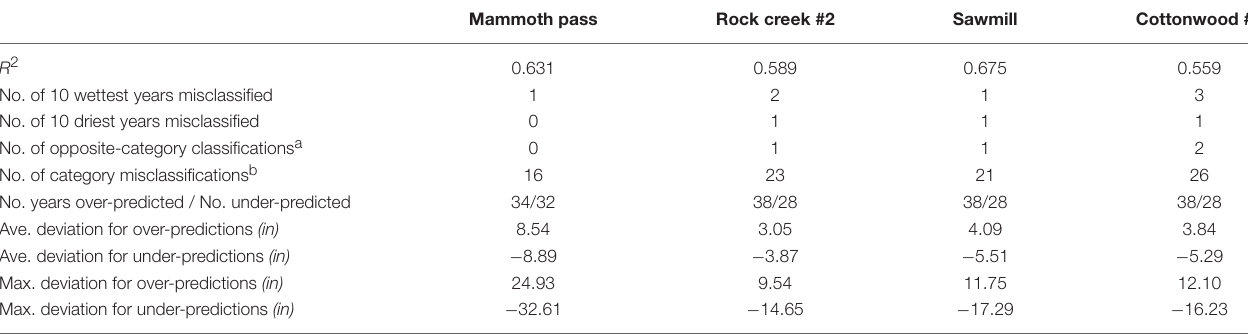
TABLE 2 | Performance measures for forecasts based on the February linear regression equations.